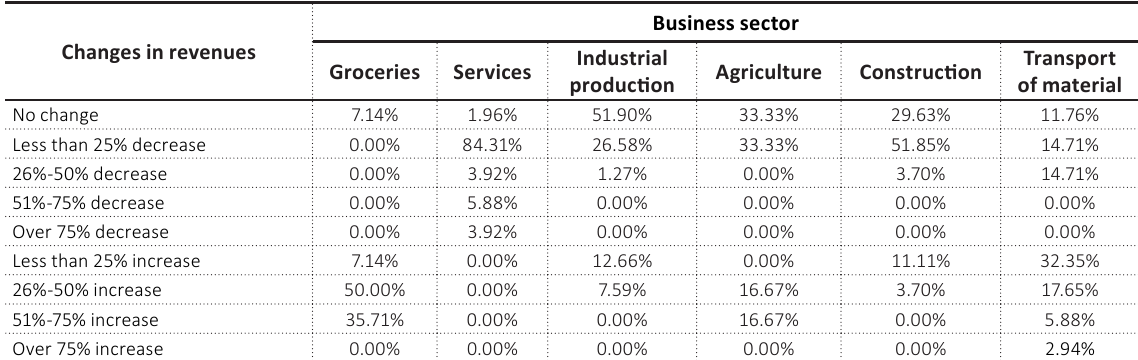
Table 4. Changes in revenues based on business